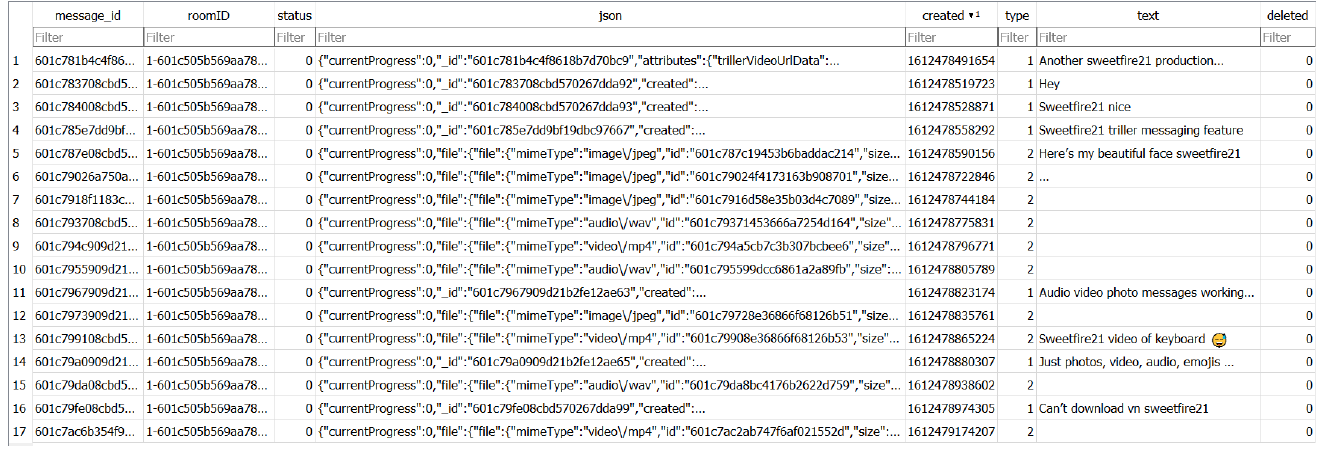
Figure 19. The messages shared between focyber86 (Android user) and focyber21 (iPhone user) on triller.db as shown in the DB Browser for